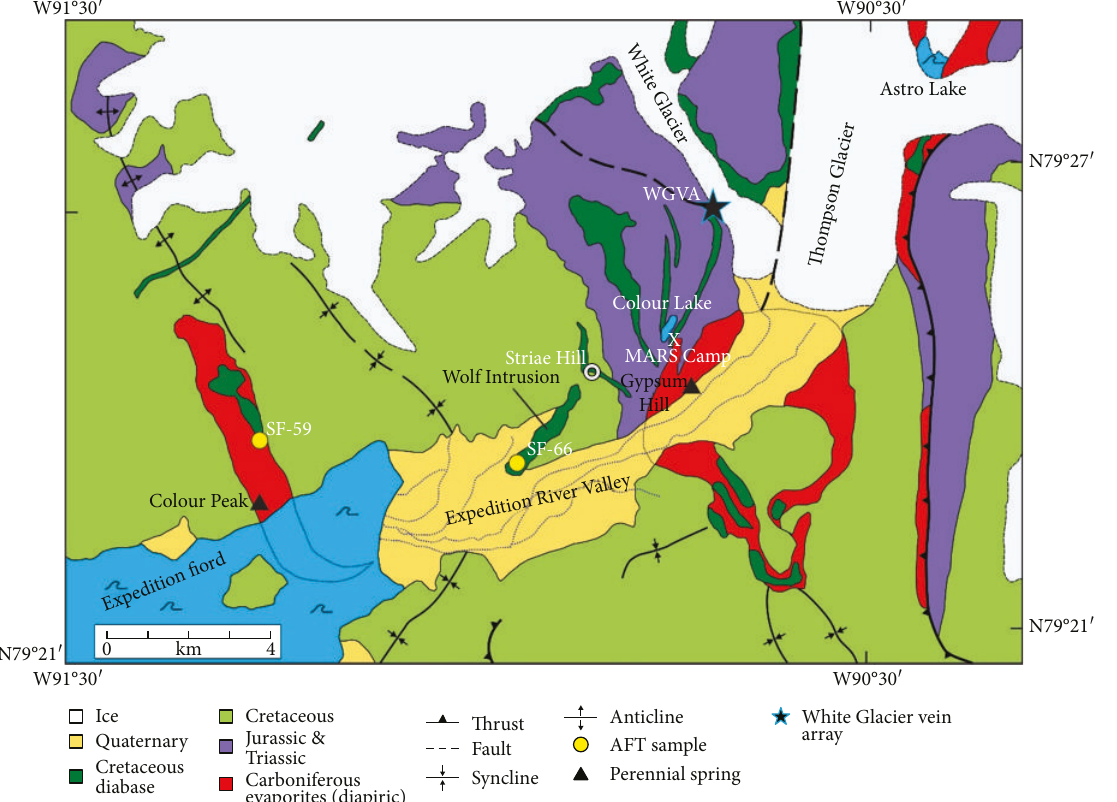
Figure 2: Generalized geological map showing the location of the White Glacier vein array site (black star) in relation to perennial springs (black triangles) and evaporite diapirs (red); purple and light green units are predominantly sedimentary strata of Mesozoic age; igneous ma fi c sills and dikes are dark green. Location of apatite fi ssion track samples in Wolf Intrusion and Colour Peak marked as fi lled yellow circles. Fluid inclusion Striae Hill sample marked by white ring. MARS Camp (McGill Arctic Research Station - X) was used as fi eld base. Geology modi fi ed from Harrison and Jackson